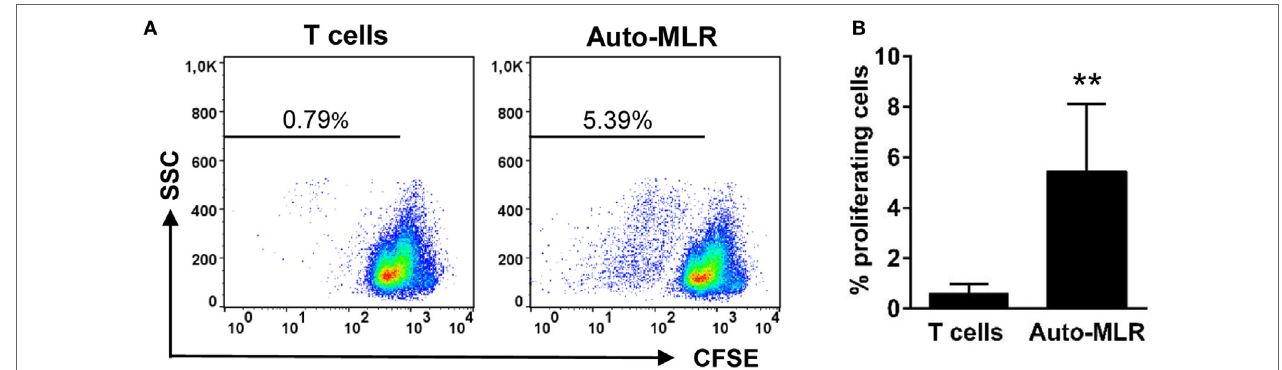
FigUre 3 | T cell-activating capacity of gill CD8 + dendritic cells (DCs). Trout gill CD8 + DCs were isolated by flow cytometry. Cells were then cultured for 12 h in L-15 medium supplemented with 20% fetal calf serum in presence of the T cell-dependent Ag TNP hapten conjugated to the keyhole limpet hemocyanin. Thereafter, DCs were cocultured with isogenic T cell-enriched fractions obtained from the spleen of these same animals [auto-mixed leukocyte reaction (MLR)], previously labeled with CFSE. Cocultures were set at a ratio of 1:30 (DC:T cells) and incubated for 5 days. After this time, the cultures were analyzed by flow cytometry to measure the level of CFSE dilution. (a) A representative example from eight individuals is shown, and the percentage of proliferating cells is indicated. (B) Average percentages of proliferating cells were calculated ( n = 8, mean + SD) (** p ≤